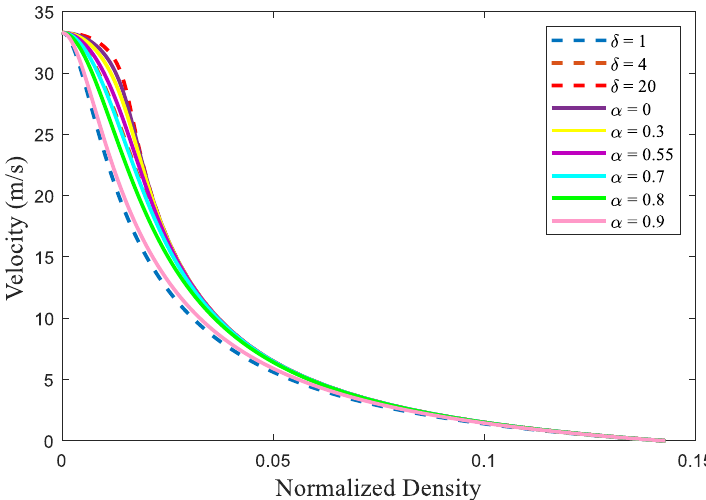
Figure 3. Velocity for the ID and proposed models over an 800 m circular road for different accel- eration exponents and weather severity indices, respectively. Table 3. Maximum flow and density, and critical velocity for the ID